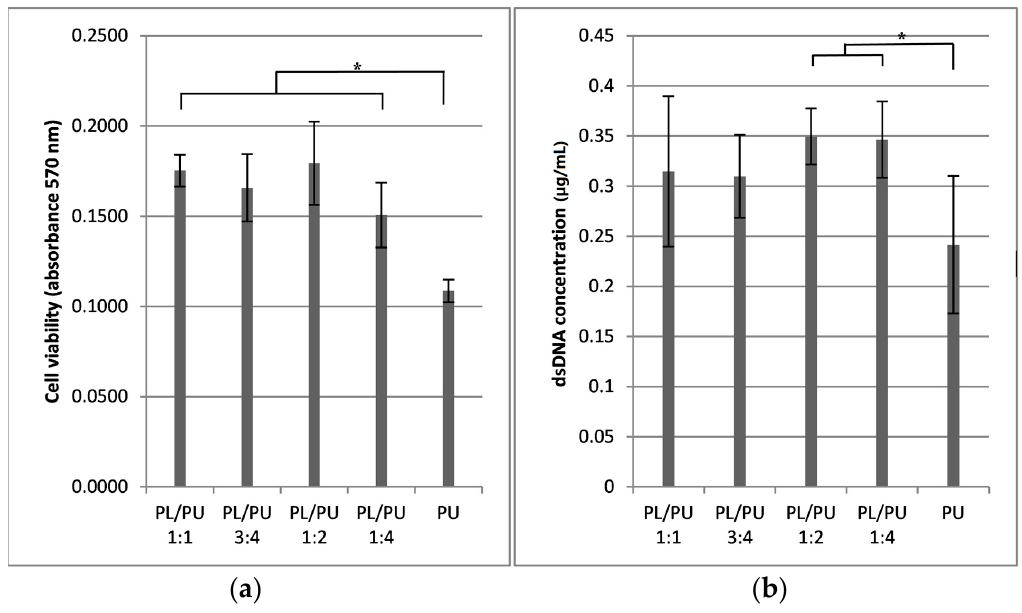
Figure 3. ( a ) Cell viability and; ( b ) dsDNA level in 7F2 culture on polyurethane composite 3 days after seeding, measured by MTT cell proliferation assay and pico-green assay respectively ( n = 5) (* p > 0.05).